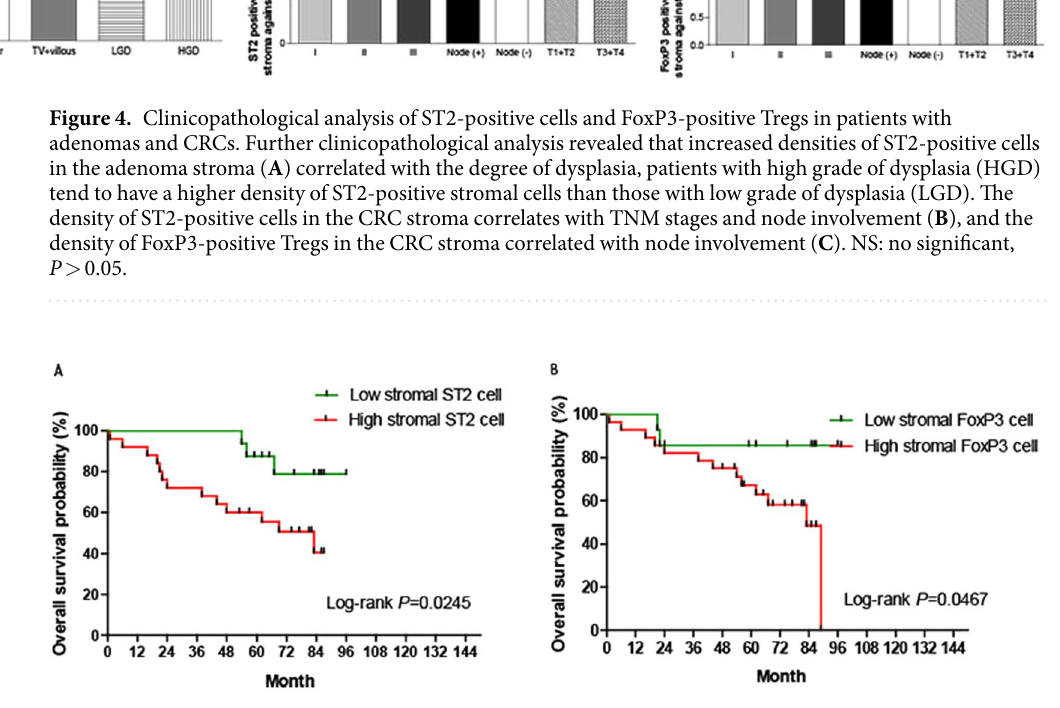
Figure 5. The Kaplan–Meier analysis of overall survival differences in CRC patients with differing density scores of ST2-positive cells and FoxP3-positive Tregs. The Kaplan–Meier analysis revealed that the density scores of ST2-positive cells ( A ) and FoxP3-positive Tregs ( B ) in the CRC stroma predicate the overall survival time in patients with CRC. CRC patients with high densities of ST2-positive cells and FoxP3-positive Tregs in the tumor stroma did have a significantly shorter overall survival time compared with those with low densities of ST2-positive cells and FoxP3-positive Tregs.